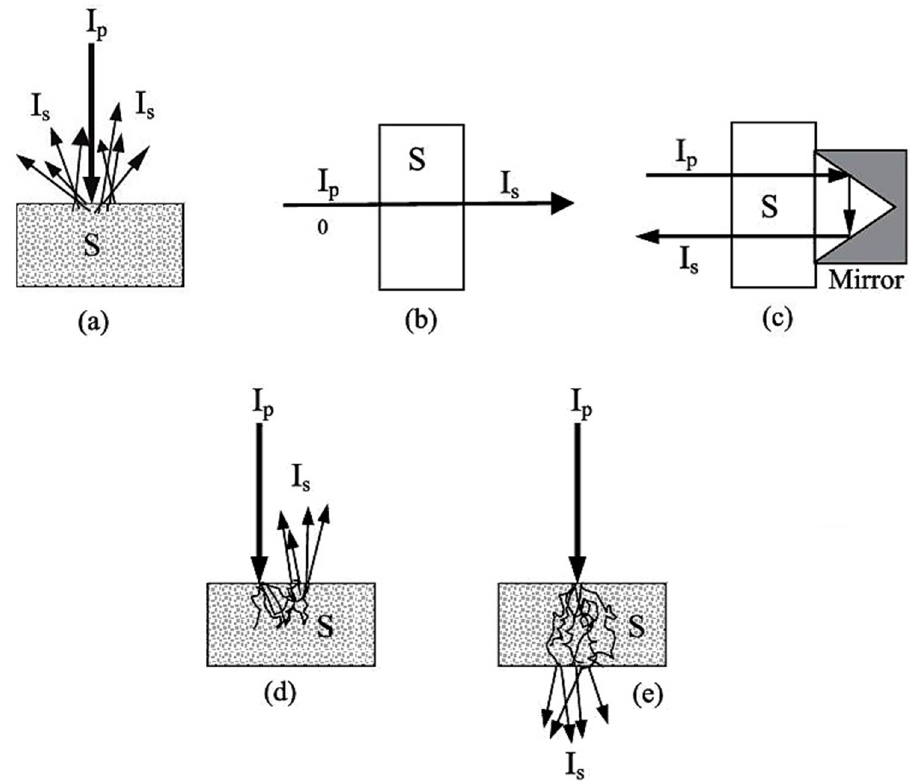
Figure 5. Modes of spectral acquisition employed in NIR spectroscopy: ( a ) diffuse reflectance; ( b ) transmittance; ( c ) transflectance; ( d ) interactance; ( e ) transmittance through scattering medium. Adopted (CC-BY 4.0 license) from [68].